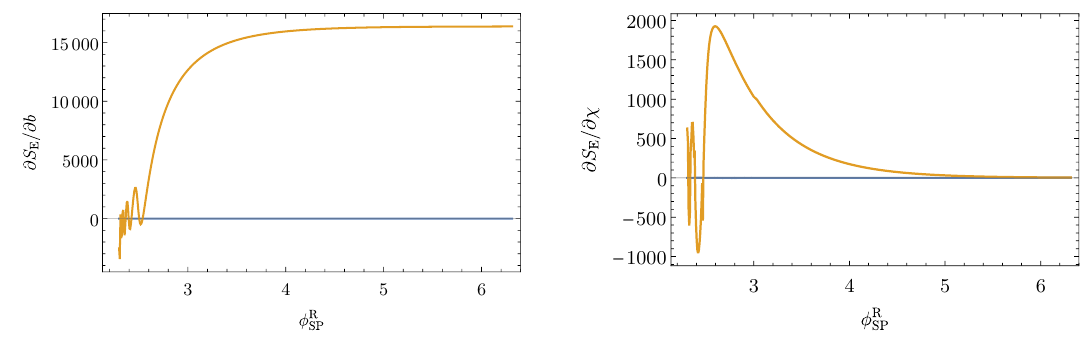
Figure 6. The derivative of the Euclidean action. The blue and orange lines correspond to the real and imaginary parts, respectively. The classicality condition is satis(cid:12)ed in most parts. (cid:11) = 1 is